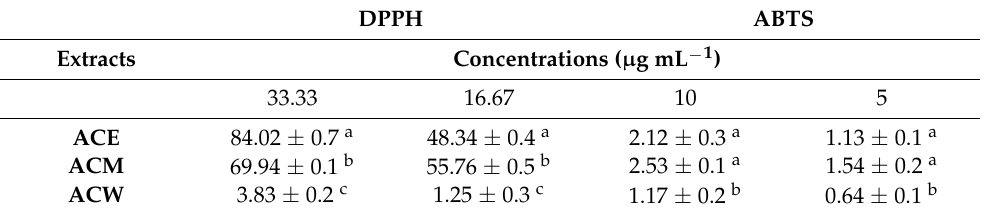
Table 2. Radical scavenging activity (ABTS and DPPH) of three extracts from A. cherimola leaves, 435 expressed as µmol of Trolox equivalents per 100 g of dry extract.